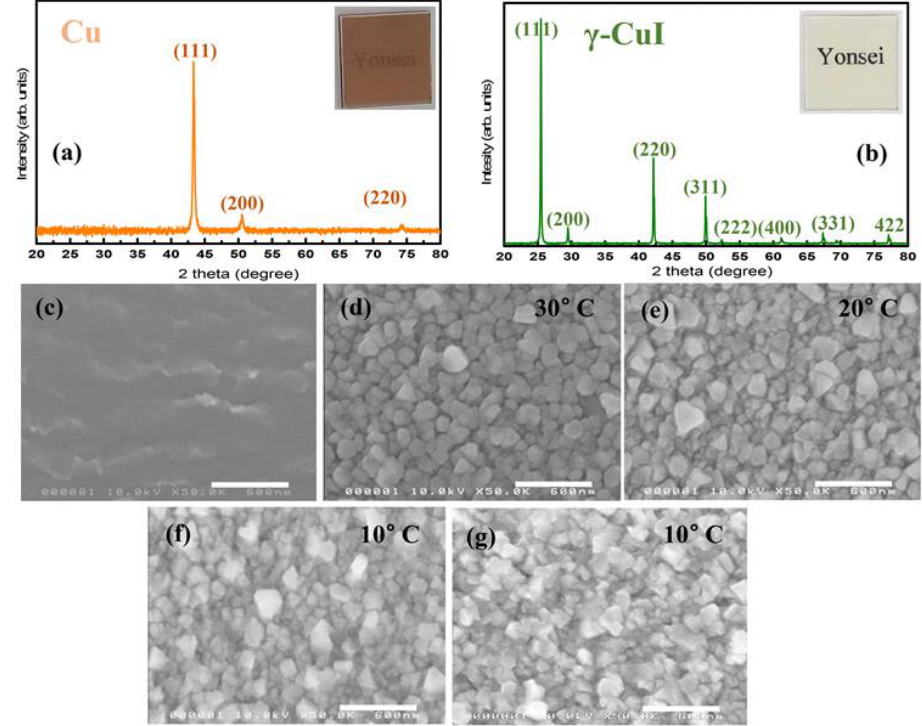
Figure 2. ( a , b ) XRD of Cu and iodized films on the glass substrate (inset shows the e-beam evapo- rated copper and iodized films, respectively). Morphology of ( c ) e-beam evaporated copper film. ( d – f ) Iodized films obtained after iodization of 20 nm copper films at different iodization tempera- tures; ( d ) 30 °C ( e ) 20 °C and ( f ) 10 °C. ( g ) Iodized films obtained at 10 °C from 30 nm thickness of copper film on glass/PDMS. Scale bars are 600 nm in ( c – g ).